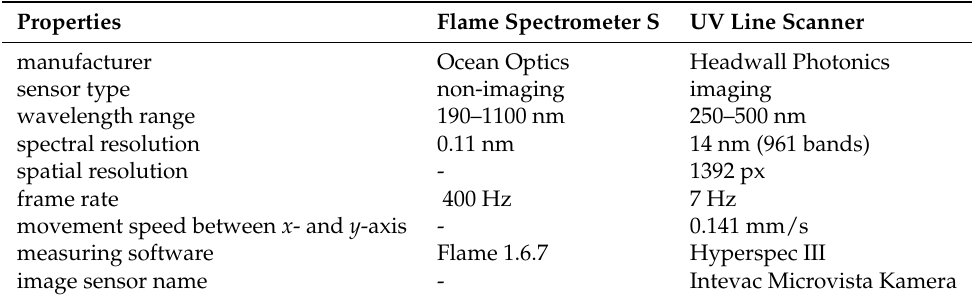
Figure 1. Hyperspectral UV-VIS imaging System with UV-VIS-line scanner, UV-light source, halogen light and line stage. Table 1. Technical properties of the Flame Spetrometer S and UV line scanner used in this